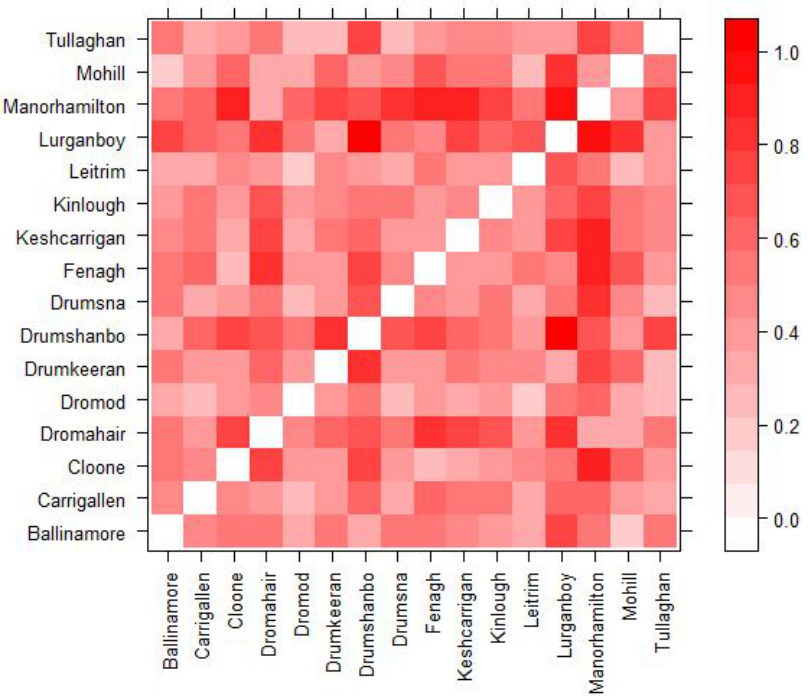
Figure 1. Distance Matrix showing the normalized euclidean distance between